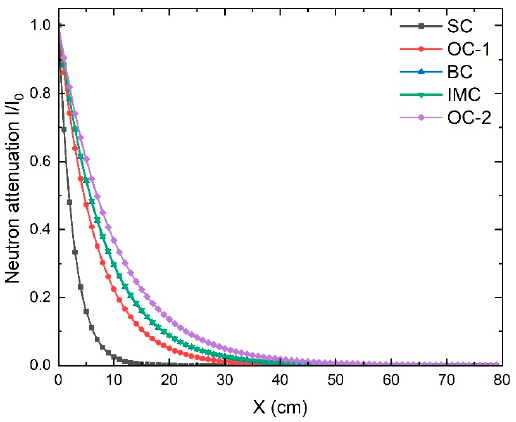
Figure 3. The variation in the neutron attenuation as a function of the concrete thickness for five concrete types, IMC, OC-1, BC, OC-2, and SC.